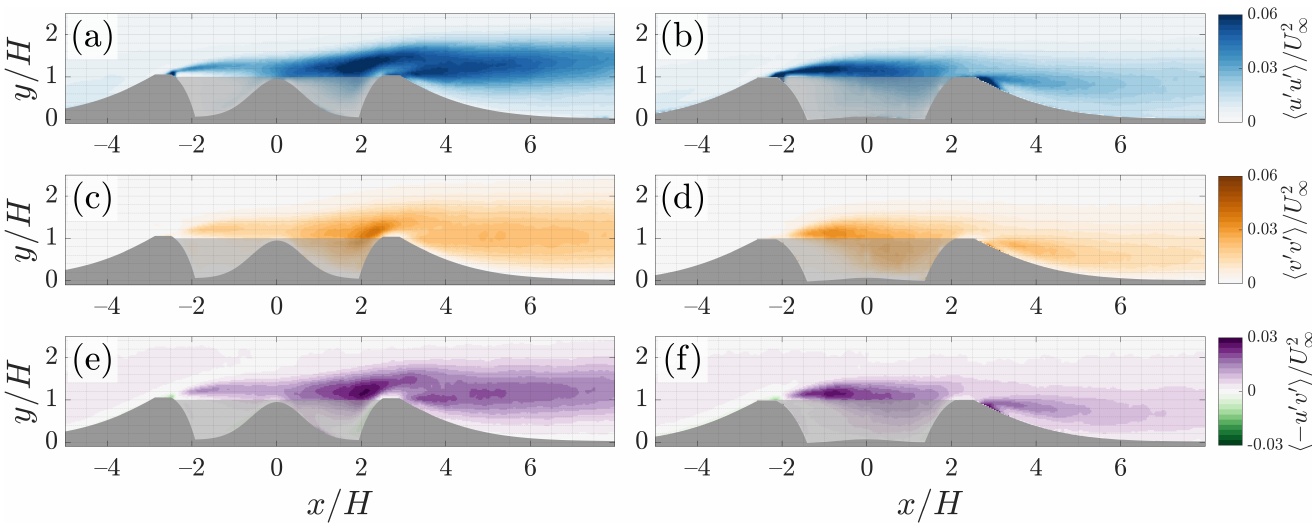
Figure 11. Contours of Reynolds stresses normalized by U 2 ∞ at the centerline plane ( left column ) and offset plane ( right column ). ( a , b ) (cid:104) u (cid:48) u (cid:48) (cid:105) , ( c , d ) (cid:104) v (cid:48) v (cid:48) (cid:105) , and ( e , f ) (cid:104)− u (cid:48) v (cid:48) (cid:105) . Re H = 8.9 × 10 3